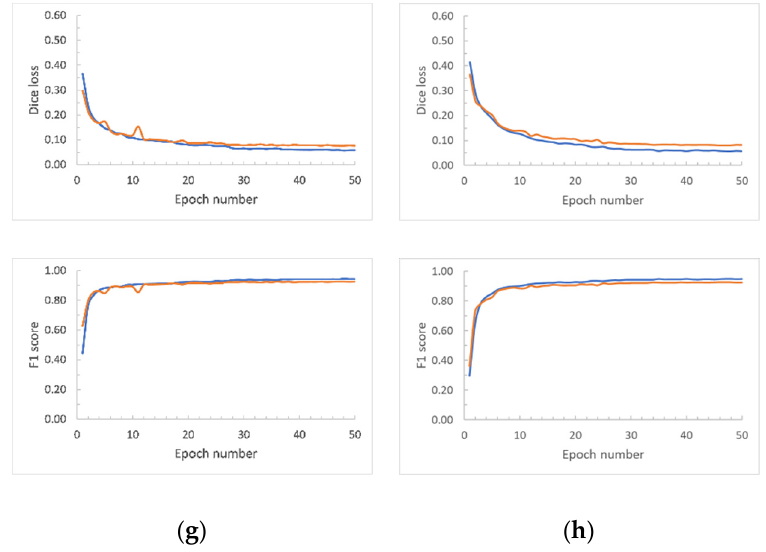
Figure 9. Training (blue line) and validation (orange line) Dice loss curves based on the hand- annotated data from Banks Island. Array sizes are shown in pixels. ( a ) Image tile size: 2048 × 2048, Network input size: 1024 × 1024. ( b ) Image tile size: 2048 × 2048. Network input size: 512 × 512. ( c )